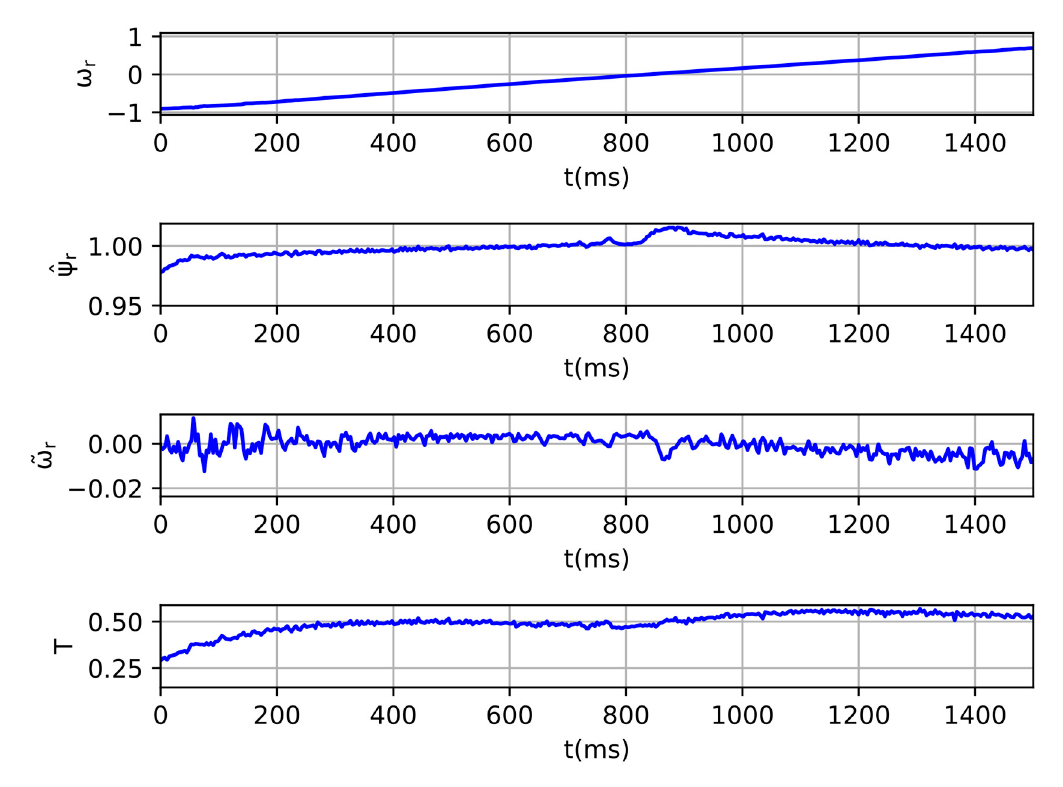
Figure 15. Experimental results during rotor direction change using the closed-loop control system.